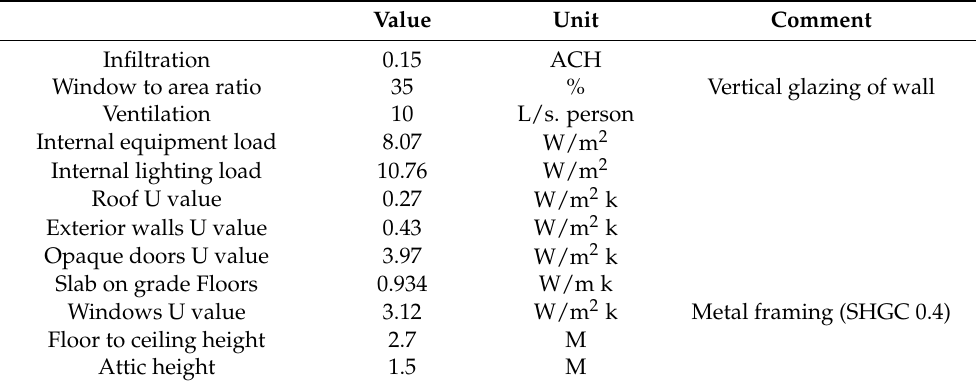
Table 1. Single residential building specification.